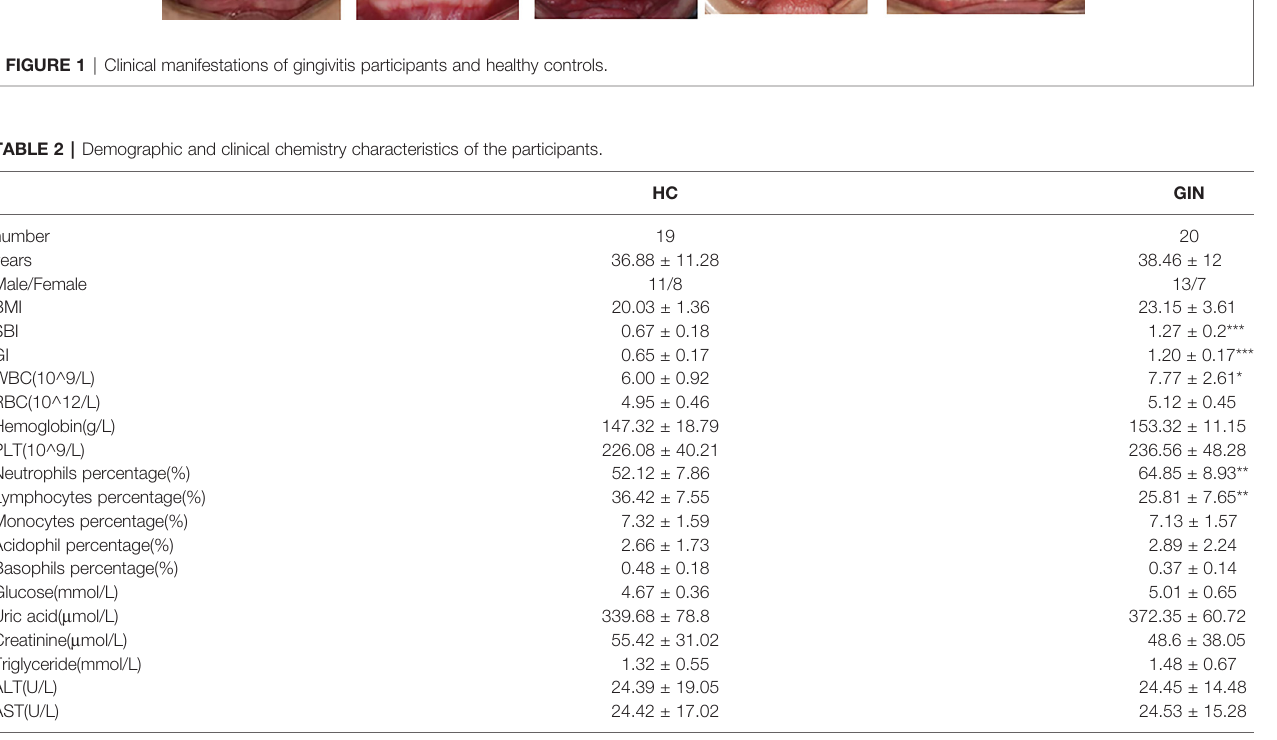
TABLE 2 | Demographic and clinical chemistry characteristics of the participants.